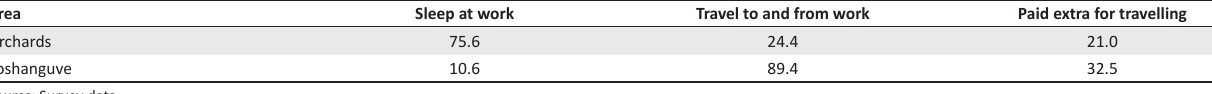
TABLE 7: Domestic workers’ travelling status – Orchards ( n = 86), Soshanguve ( n = 85). Area Sleep at work Travel to and from work Paid extra for travelling Orchards